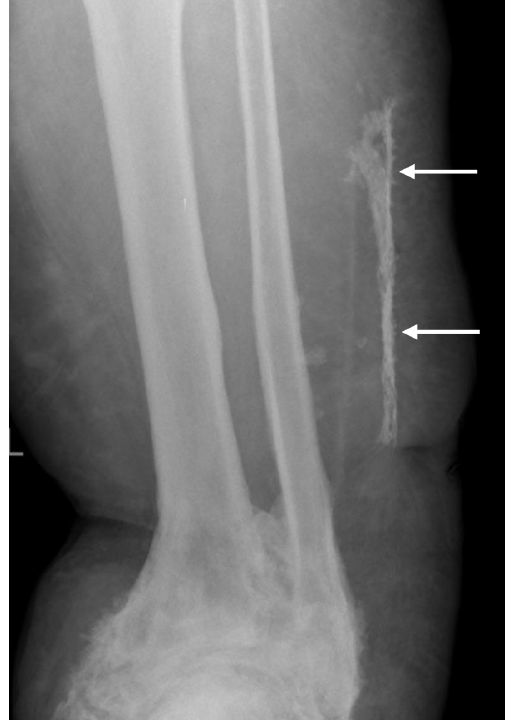
Figure 2. Plain X-ray showed the area of new bone formation in the lateral soft tissues (white arrows), separate from the fibula. The ankle joint has extensive heterotopic bone formation, deformity and